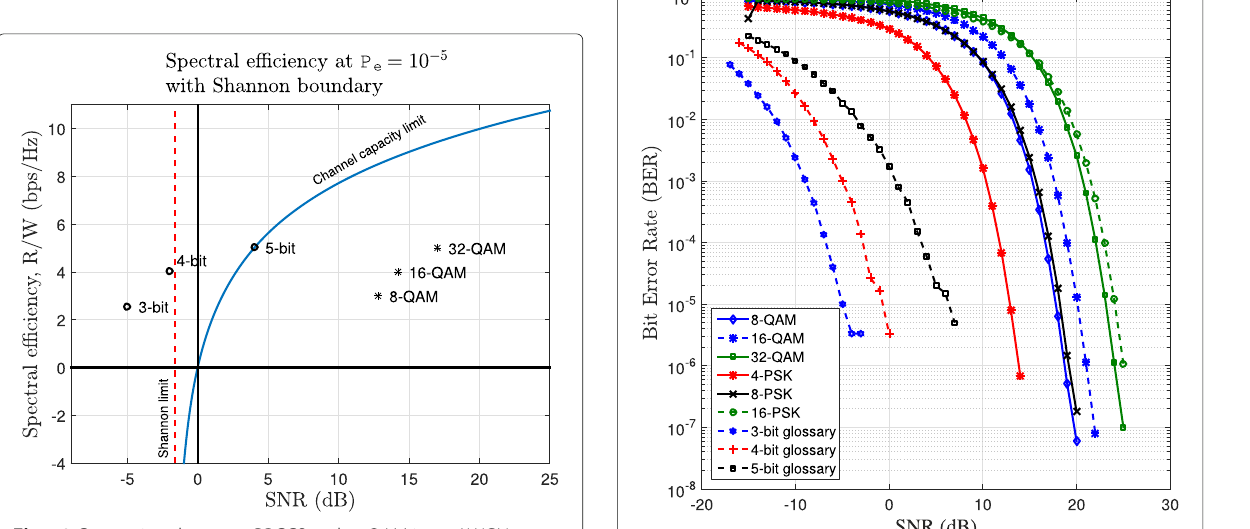
Fig. 12 Comparison between PBCCS and m -QAM in an AWGN channel at P e = 10 − 5 bit error probability. The neural network contains 20 hidden neurons